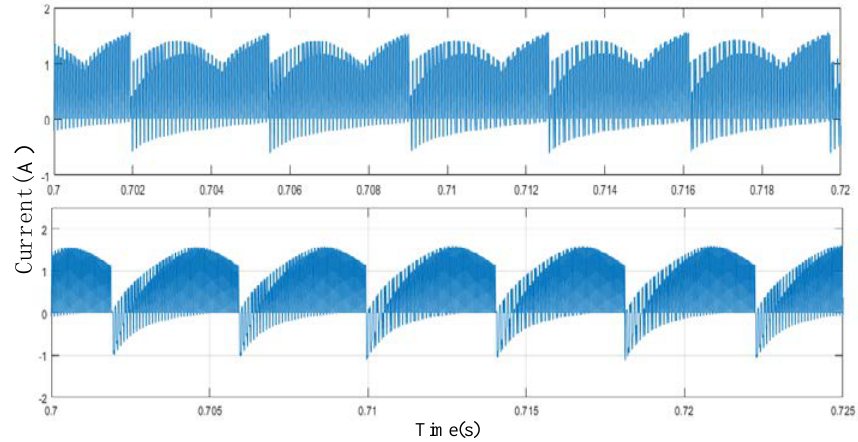
Figure 19. DC-bus current with speed closed-loop.